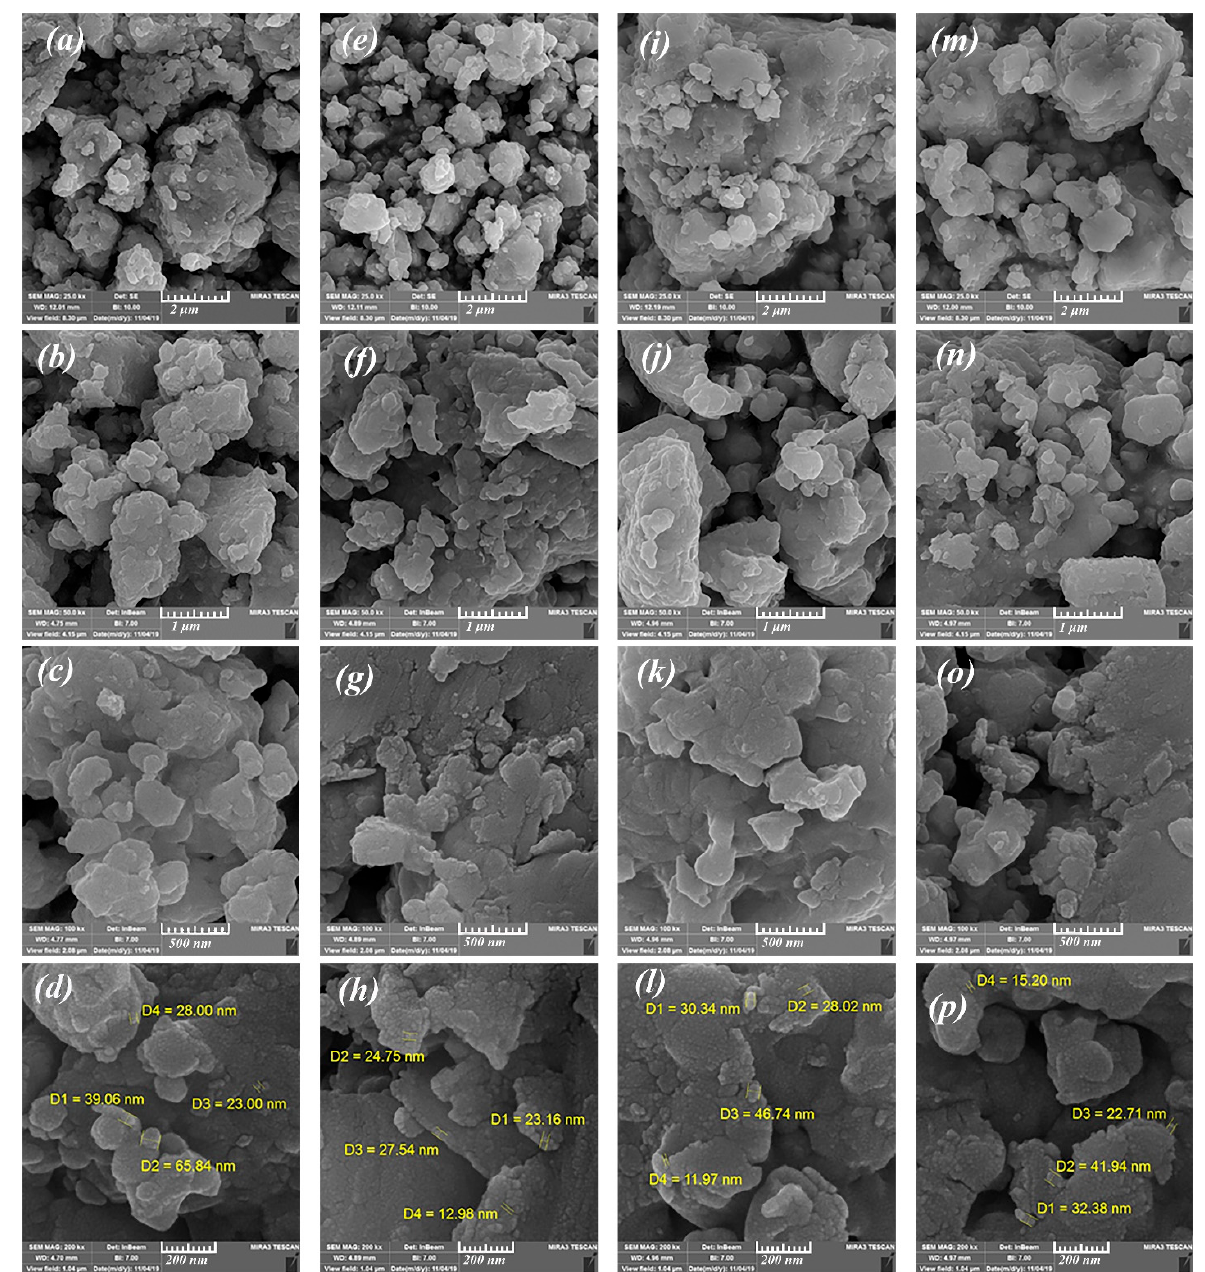
Figure 1. Images of FESEM microscope from the samples: ( a – d ) S1, ( e – h ) S2, ( i – l ) S3, and ( m – p ) S4 synthesized by ball milling under annealing treatment.